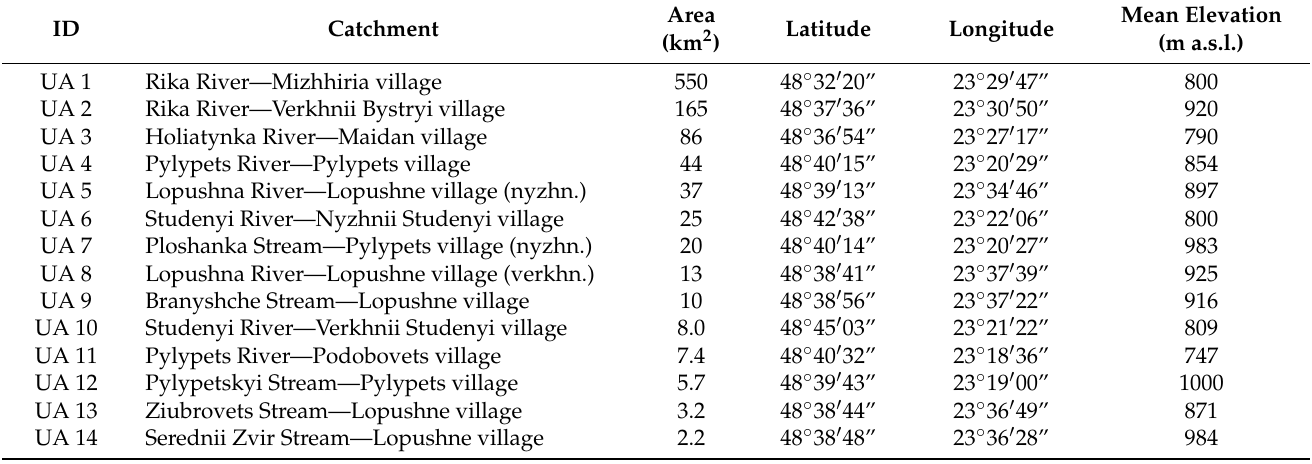
Table 1. Characteristics of the catchments and geographical coordinates of the catchment outlets in the upper Rika River Basin